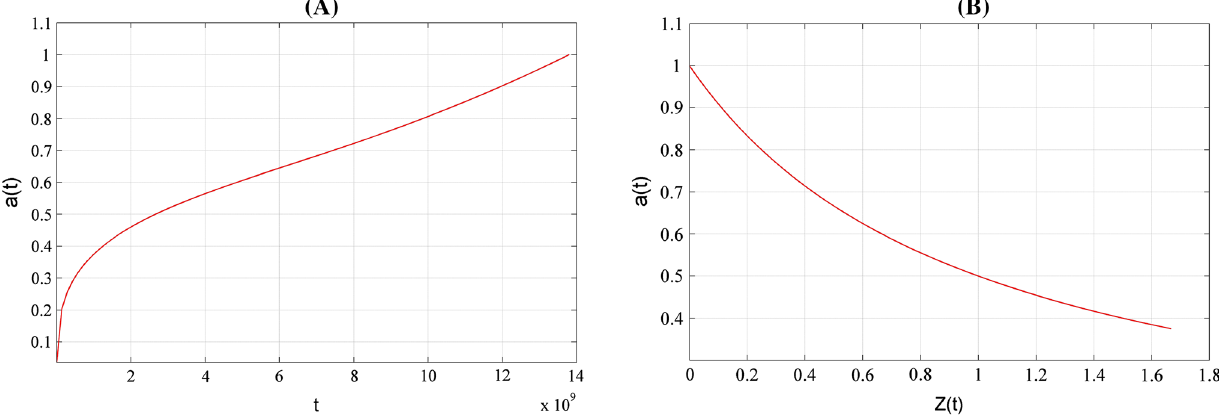
Fig. 1 Plot a indicates the scale factor a ( t ) versus time t at the time range [0.7Myr, 13.8Gyr] while b shows the scale factor a ( t ) versus redshift z at the time range [1Gyr, 13.8Gyr]